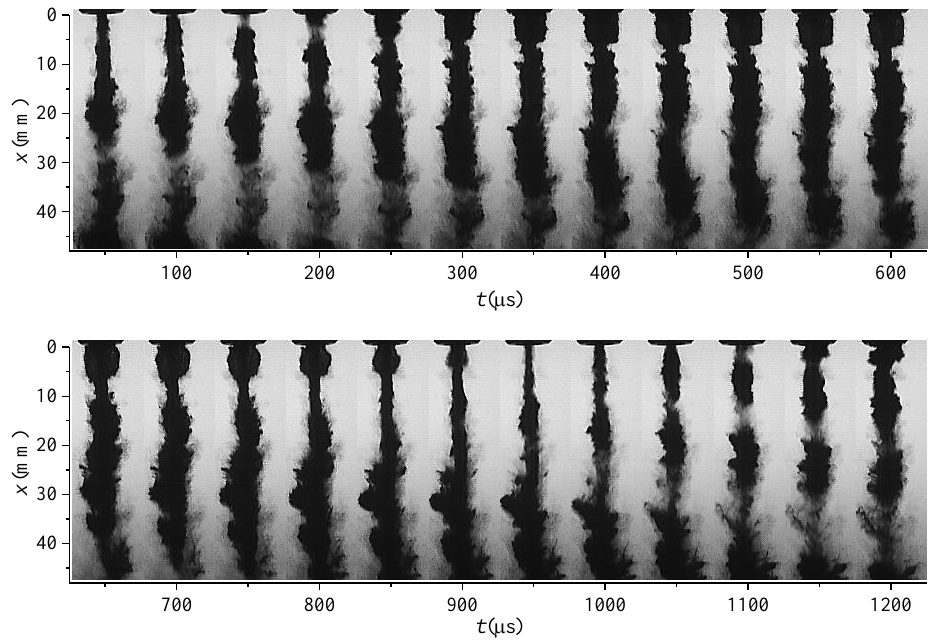
Figure 5. Cavitation cloud image of organ pipe nozzle with divergent whistle. A total of 5000 high-speed photographic images of a continuous cavitation jet were selected for the POD. Figure 6 shows the zeroth- to seventh-order modes of the POD in the jet cavitation region, where the M0 corresponding to ϕ 1 represents the average change of the gray level of the cavitation images at each position in the analyzed time period. It can be seen from the M1 image that the state corresponding to the first-order mode is the growth stage of the cavitation. At this time, spherical cavitation groups are generated at the exit of the nozzle, while the cavitation from the outlet of the nozzle to the downstream 20 mm segment is in the growth stage. M2 and M1 have the same frequency and the two modes appear alternately. Combined with the M2 modal diagram, it can be seen that under this mode, the cavitation cloud falls off and the nozzle outlet segment begins to collapse. The subsequent modes of M3 have a relatively low percentage of energy, which corresponds to the expansion and contraction of the boundary layer and the fluctuation caused by the turbulence in the evolution cycle of the cavitation cluster.